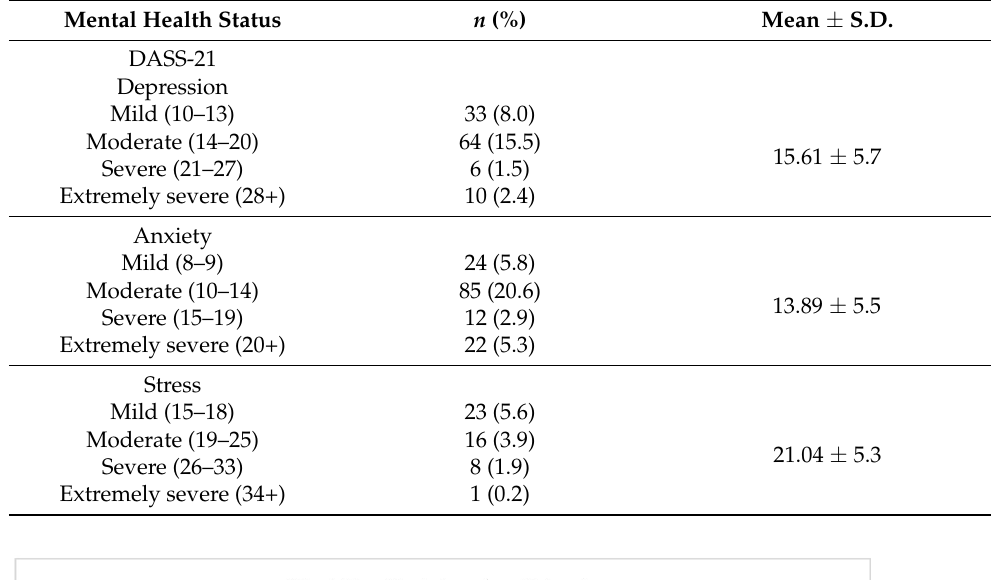
Table 2. Mental health status of participants.